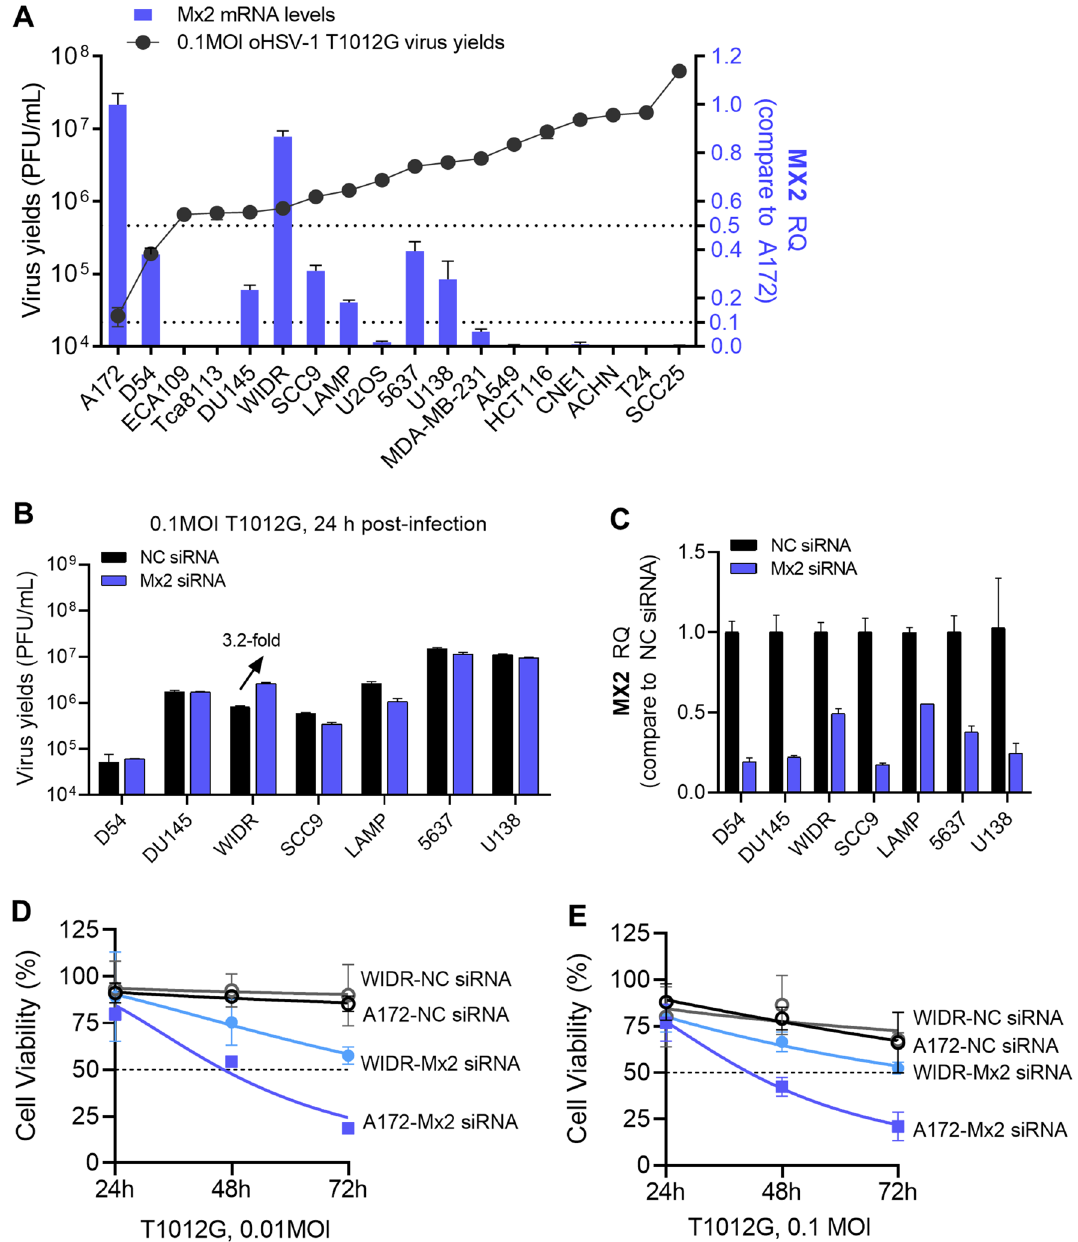
Figure 6. The potential association of Mx2 with oHSV-1 resistance in other human tumor cell lines. ( A ) The mRNA accumulation of Mx2 in other human tumor cell lines. RQ: relative quantity, values were compared with Mx2 mRNA levels in A172 cells. ( B ) Virus yields in Mx2-depleted D54, DU145, WIDR, SCC9, LAMP, 5637 and U138. Mx2 was knockdown in above human tumor cells lines by siRNA transfection. Treated cells were exposed to 0.1 MOI T1012G, virus progeny was harvested at the 24 h post-infection and titrated in Vero cells. ( C ) Investigation of Mx2 knockdown efficiency by RT-qPCR assay. ( D , E ) The cell viability of Mx2-depleted A172 cells and WIDR cells. Mx2-depleted and mock-depleted A172 cells or WIDR cells were infected with oHSV-1 T1012G at an MOI of 0.01, 0.1 MOI, and cell viability was analyzed every 24 h over a time course of 72 h with CCK-8 Assays